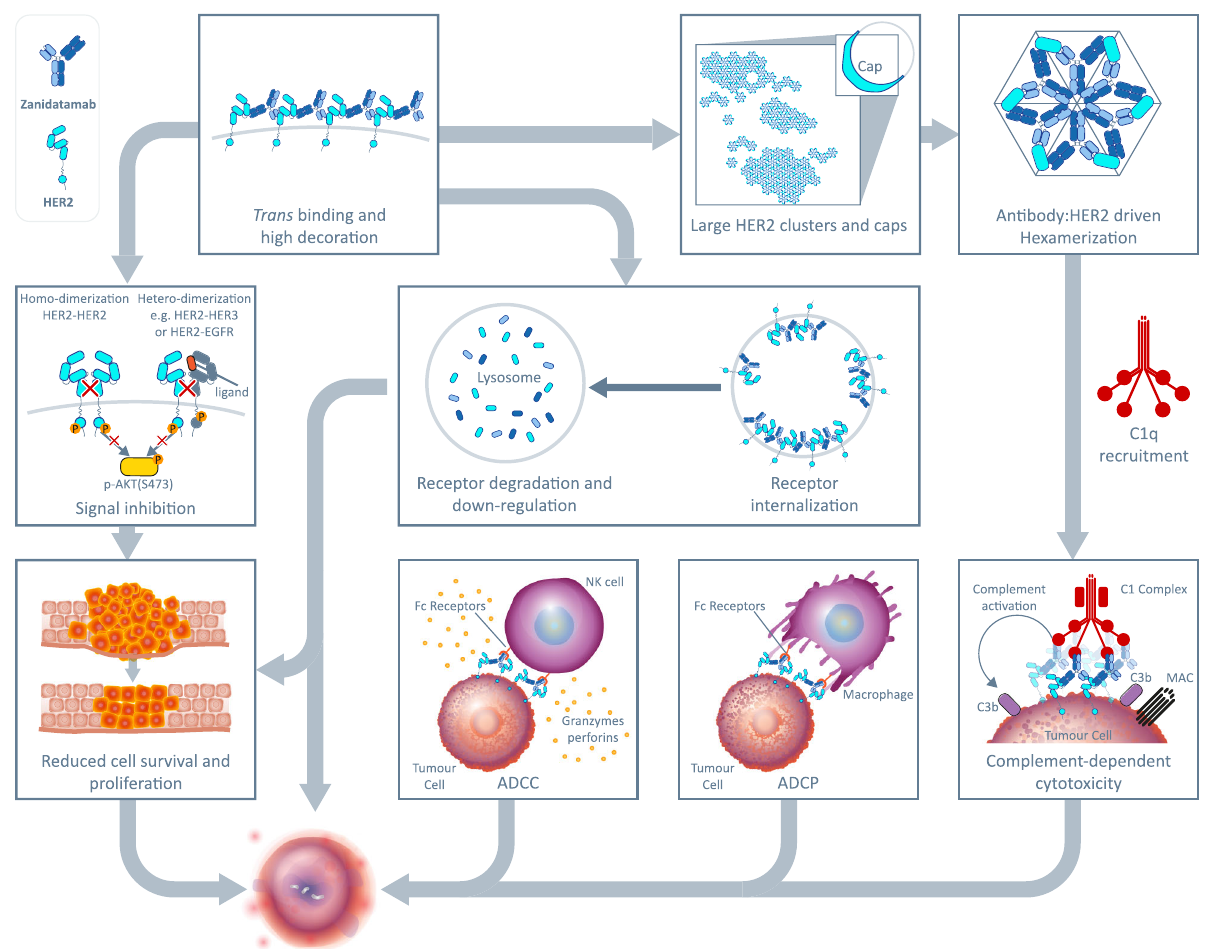
Fig. 8 | Zanidatamab has multiple mechanisms of action. We hypothesize that the trans biparatopic HER2 binding properties of zanidatamab forms the founda- tion of its multiple mechanisms of action. Zanidatamab binding leads to approxi- mately 1.5-fold increased cell surface Ab saturation as well as to receptor crosslinking. The large cell surface HER2 clusters mediated by zanidatamab engagement facilitate C1q binding, likely by promoting hexamerization, and elicit potentCDCinHER2-highcelllines.InallHER2-expressingcells,includingHER2-low tumors,ADCCandADCPactivitieswerealsoobserved.Itisalsolikelythatreceptor